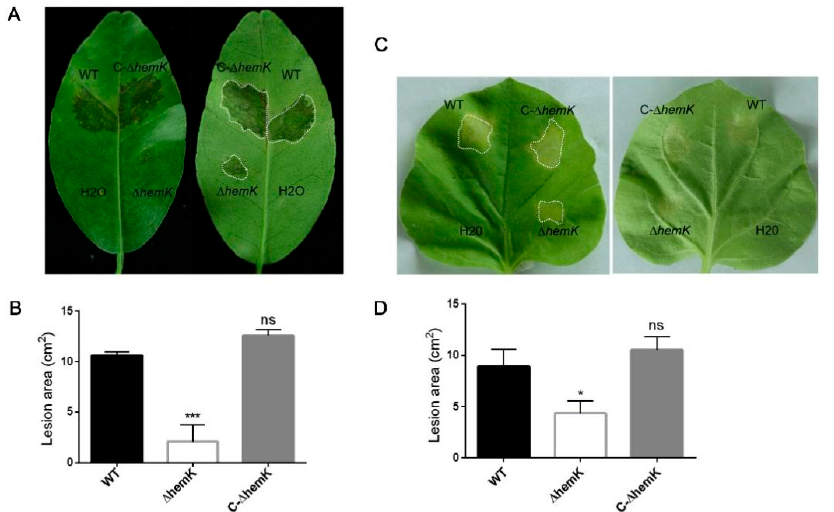
Figure 3. HemK regulates the virulence and hypersensitive response of plants. ( A ) Pathogenicity assay for wild-type, ∆ hemK , and C- ∆ hemK was performed on citrus leaves. The bacterial suspensions (approximately 10 5 CFU/mL in XVM2) were inoculated into the young leaves of sweet orange by pressure infiltration with a needleless syringe. Sterile H 2 O was used as a negative control. A representative leaf from three replicates was photographed 10 days post-inoculation. ( B ) The area of the lesions was determined by ImageJ. The means and standard errors of three replicates from one representative result are shown. The significant difference between the WT and ∆ hemK with respective treatments: *** p < 0.001 (Student’s t -test). ( C ) The symptoms of hypersensitive response were photographed 3 days post-inoculation on the leaf surface of N. benthamiana . ( D ) The area of the infection spot was measured using ImageJ. Sterile H 2 O was used as a negative control. The means and standard errors of three replicates from one representative result are shown. The significant difference between the WT and ∆ hemK, with respective treatments: * p < 0.05, ns: no significance (Student’s t -test).